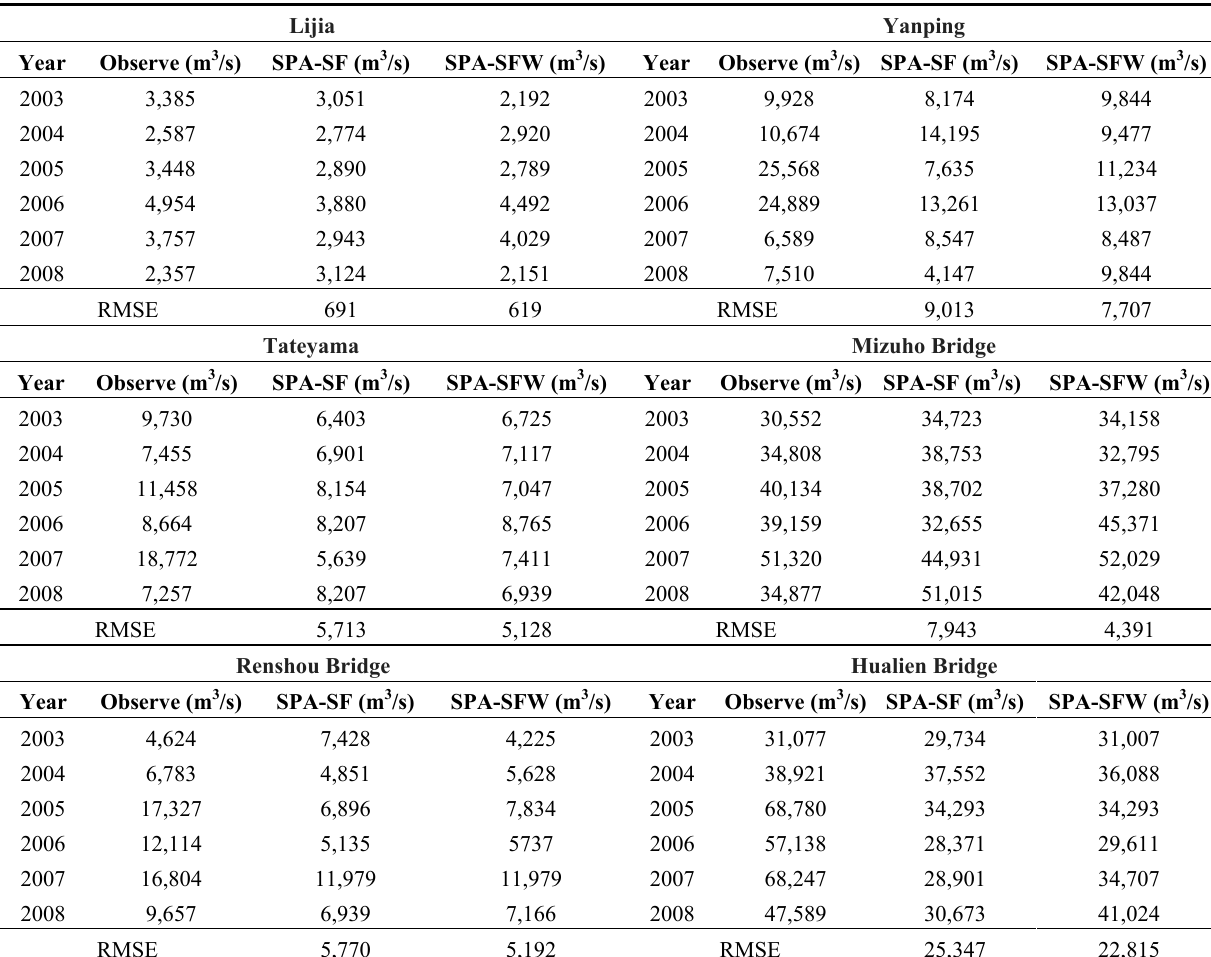
Table 4. The forecasting results obtained using the SPA-SF and SPA-SF model and wavelet denoising (SPA-SFW) based on the RMSE for six stations. Lijia